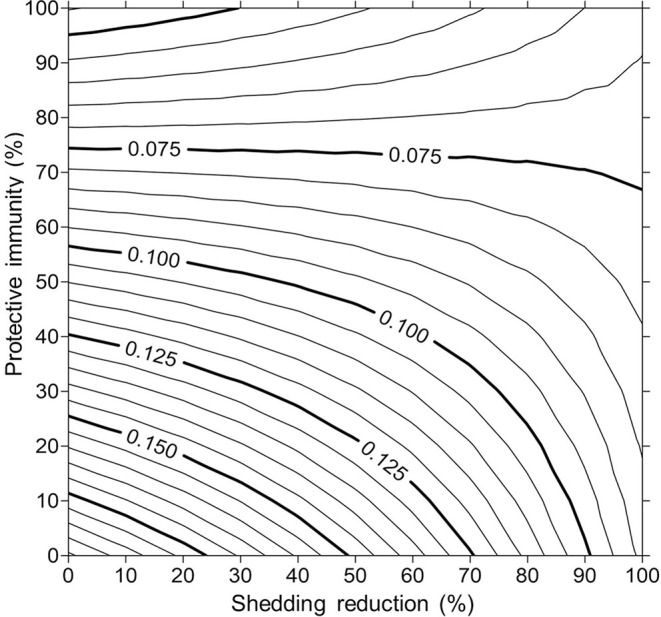
Estimates of final 10-year within-herd prevalence across a range of protective immunities and shedding reductions given an initial within-herd Mycobacterium avium subsp. paratuberculosis (MAP) infection prevalence of 0.10.